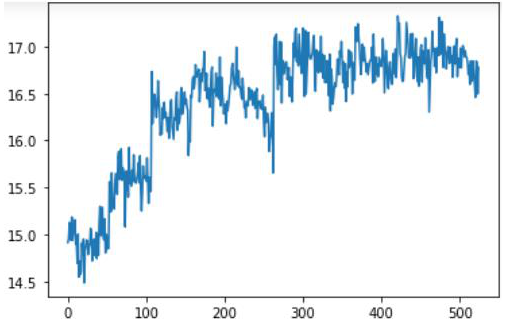
Figure 21. Merged magnetometer sensor data ( y -axis; CCIS/KSU).